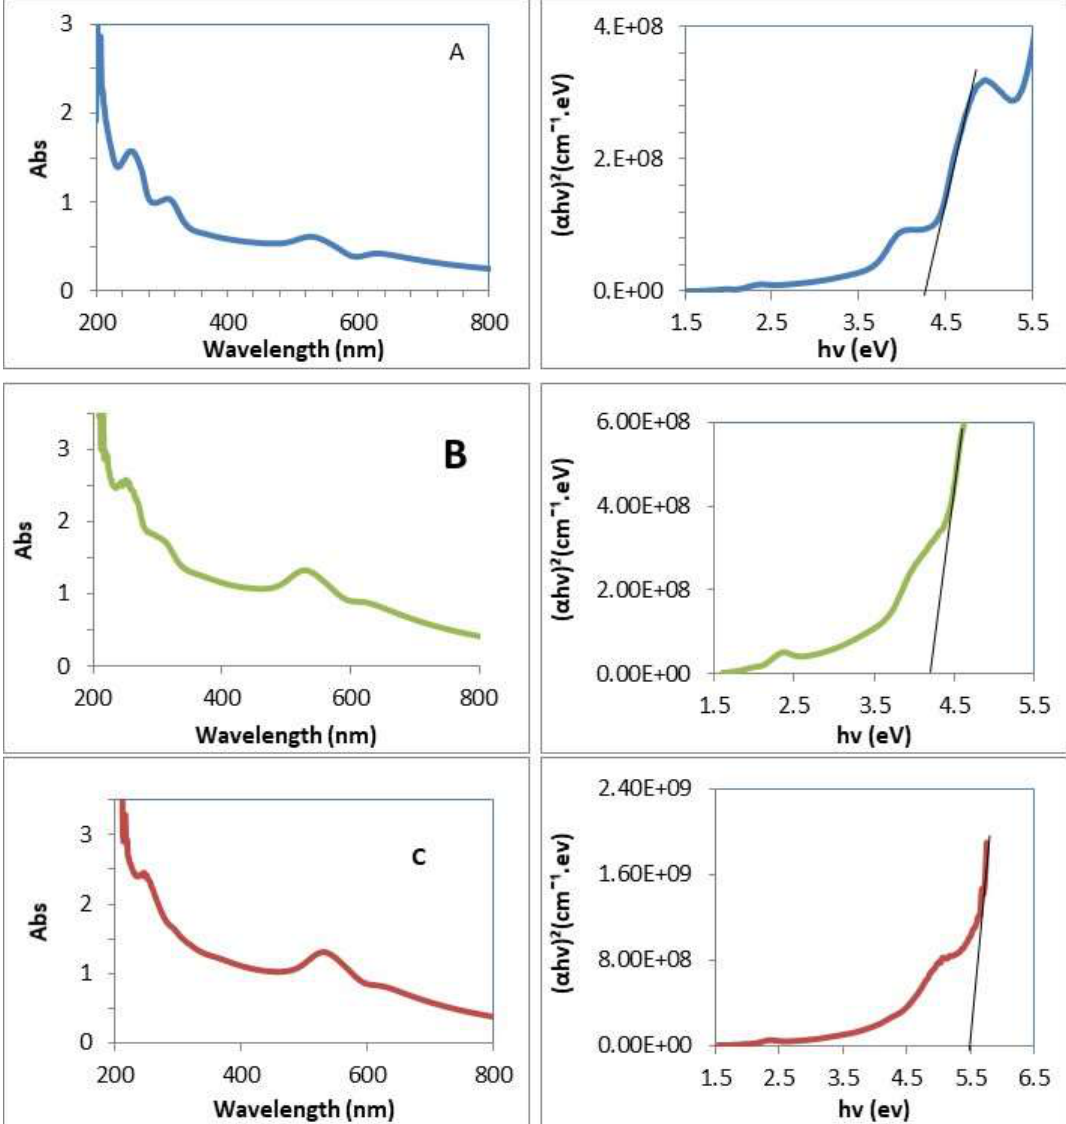
Figure 3: shows absorption of Au: TiO 2 NPs prepared at different laser energy (A) 600, (B) 800, and (C) 1000mJ 100 pulses and laser wavelengths 1064nm, with The energy band gap of Au: TiO 2